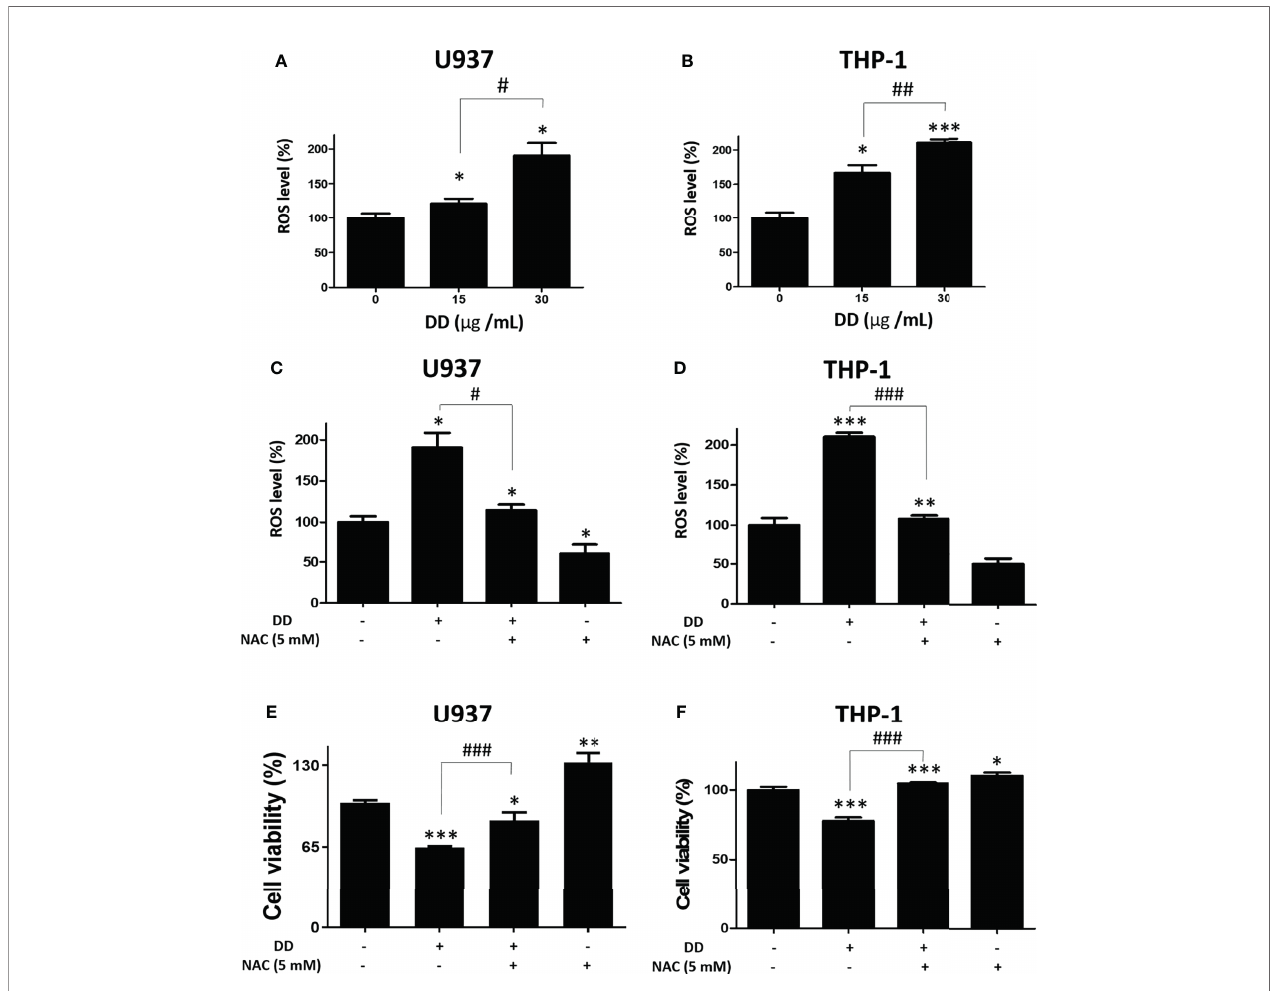
FIGURE 5 | Daemonorops draco Blume (DD) increased reactive oxygen species (ROS) accumulation and N-Acetyl-L-cysteine (NAC) pretreatment reversed the cytotoxic effect of DD in U937 and THP-1 cells. (A, B) Both cells were incubated with 20- m M 2 ’ ,7 ’ -dichloro fl uorescin diacetate (DCFDA) for 30 min at 37°C in the dark and subjected to ROS assay. The cells were exposed to 30- m g/ml DD for 4 h. DCFDA fl uorescence was determined using a dual microplate reader. (C, D) Both cells were exposed to NAC (5 mM) pretreatment for 60 min and subjected to ROS measurement. (E, F) A cell viability assay was conducted with absorbance measurement using an optical spectrometer. (Ex/Em = 450/570). Values represent the means of three experiments. Means ± standard deviation; * p < 0.05, ** p < 0.01, and *** p < 0.001 compared to untreated control group. # p < 0.05 and ### p < 0.001 between the two